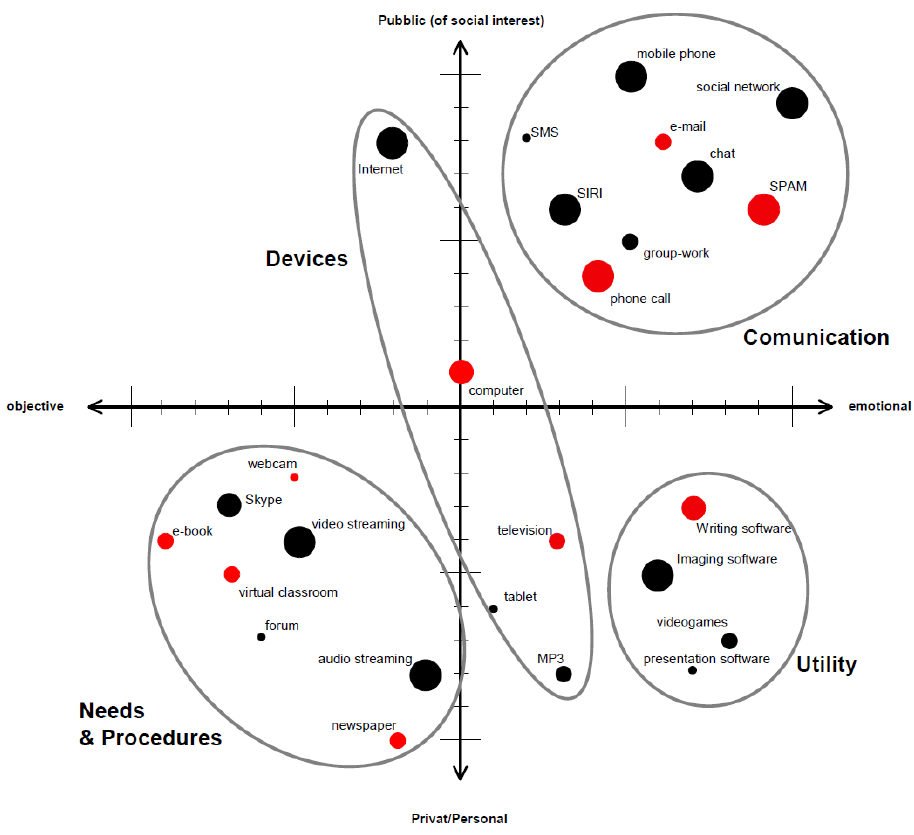
Figure 1. Diagram representation (Show & Tell) derived from the questionnaire